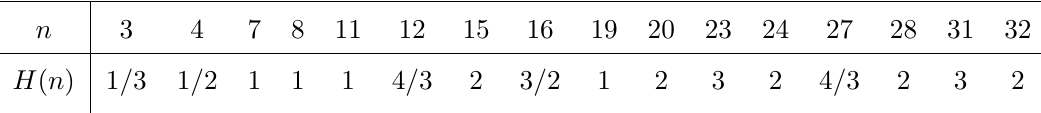
table 1. By convention we have the value H (0) = (cid:0) 1 = 12, and H ( n ) = 0 for n <